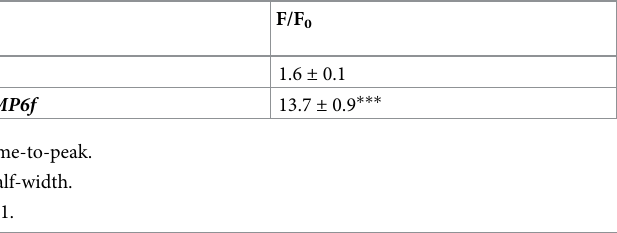
Table 3. Comparison of 5 ns—evoked Ca 2+ responses in ACC derived from wt and Sox10-GCaMP6f mice.